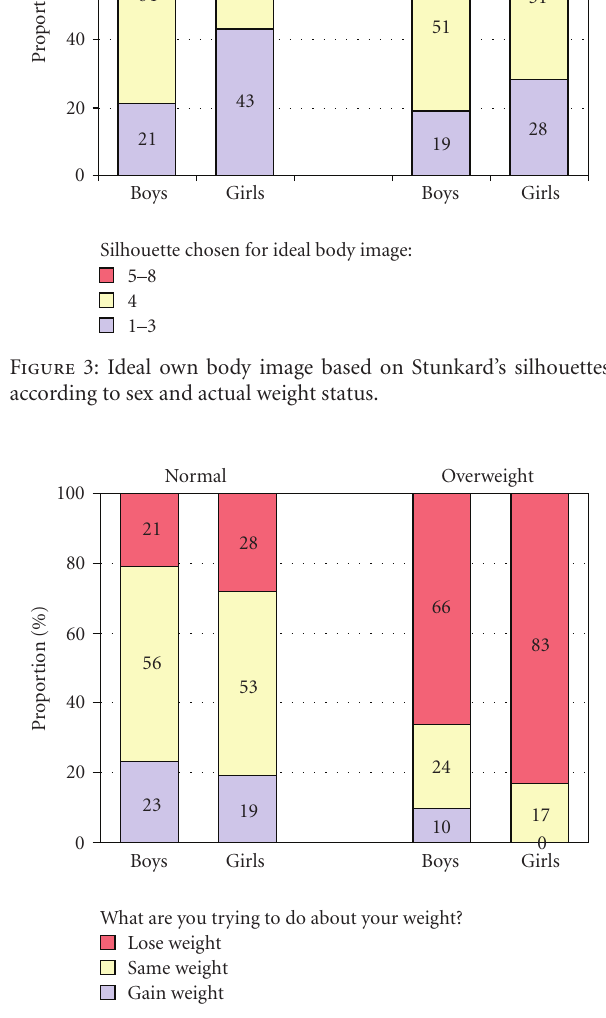
Figure 4: Weight-related behavior according to sex and actual weight